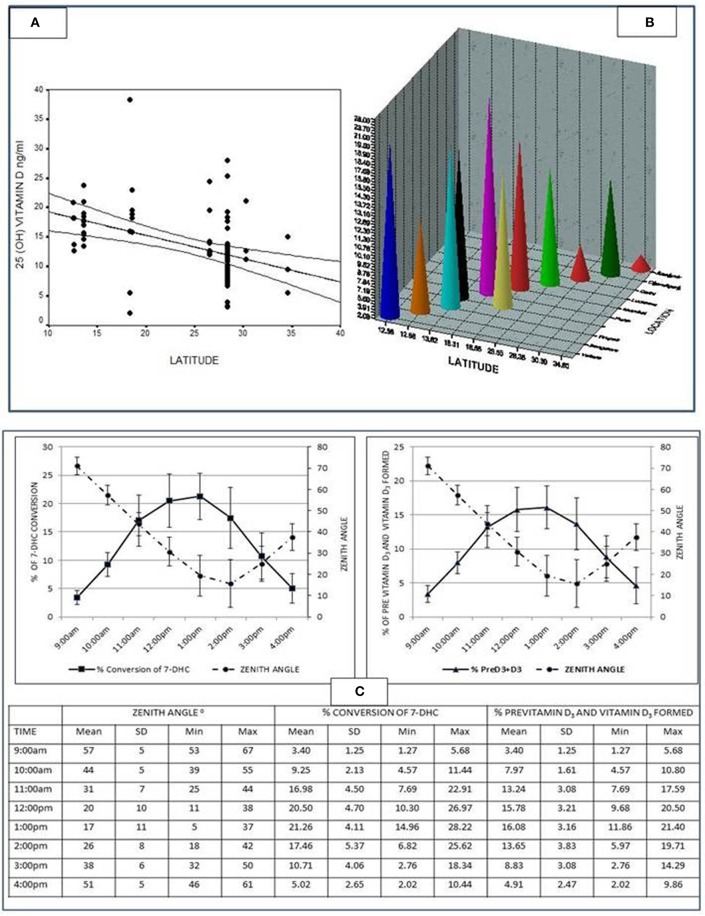
(A) Graph showing the inverse correlation between the 25(OH)D levels and latitude (r = −0·48; p < 0.0001) from various studies conducted in the country [Table 1 of (24)]. Adapted from Harinarayan et al. (24). (B) The 25(OH)D levels of various studies from India along with latitude and location from various studies conducted in the country [Table 1 of (24)]. Adapted from Harinarayan et al. (24). (C) Graph showing percent conversion of 7-Dehydrocholesterol (7-DHC) to previtamin D3 and photoproducts, and the percentage of previtamin D3 and vitamin D3 against time (for the study duration). The table below gives the individual values, mean ± SD minimum and maximum of the variables [Figure 2 of (25)]. Adapted from Harinarayan et al. (25).